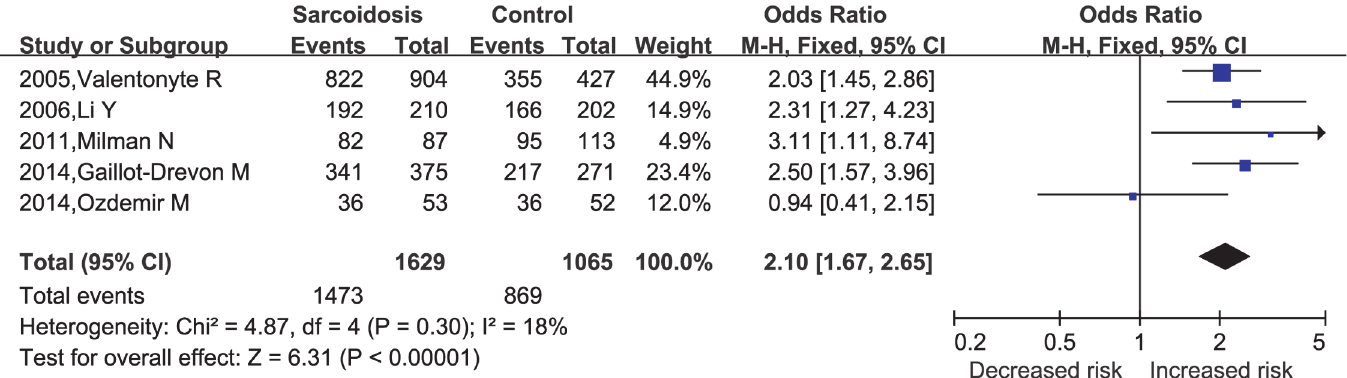
Fig 3. Forest plots of OR with 95% CI for the association of BTNL2 rs2076530 polymorphism and sarcoidosis susceptibility in AA+AG vs